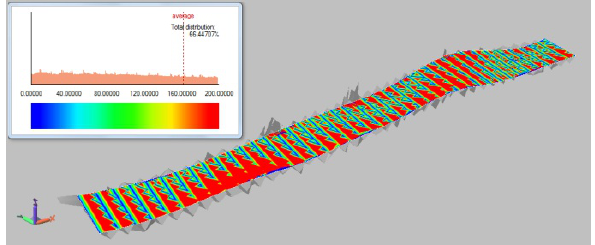
Fig.8: Comparison between ideal model and TIN